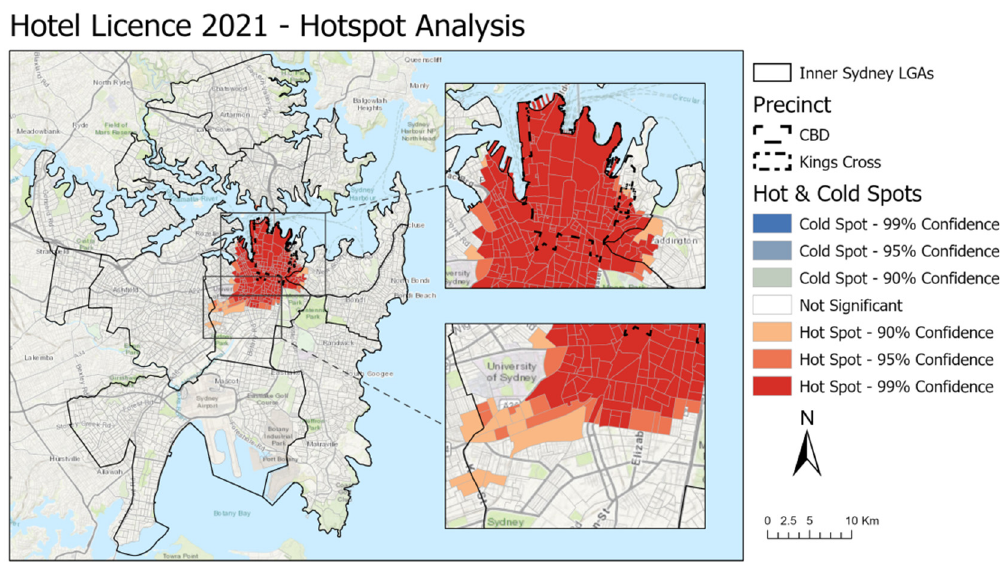
Figure 9. Licensed hotel hotspots 2021.